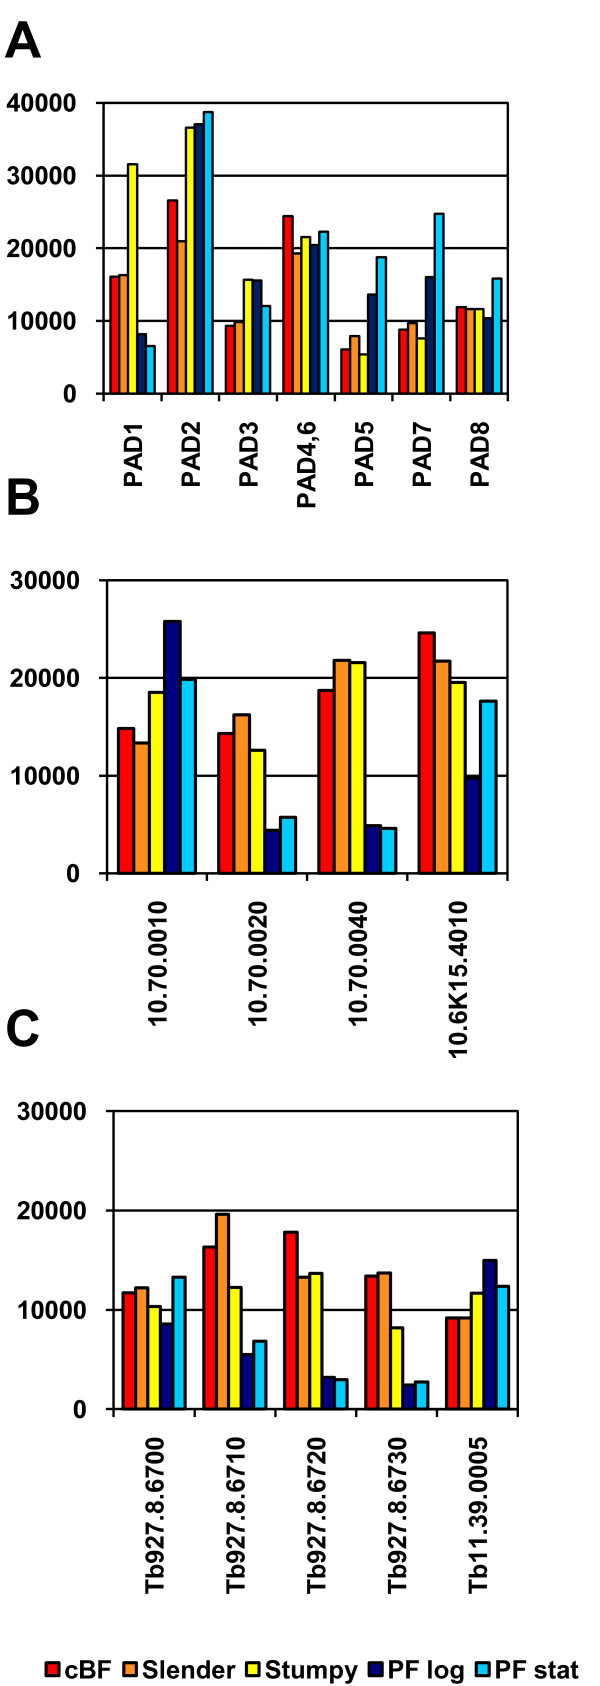
Differential expression of tandemly arrayed genes. A. The PAD gene array of carboxylate transporter proteins (PAD1, Tb9277.5930, PAD2, Tb927.7.5940, PAD3, Tb927.7.5950, PAD4, Tb927.7.5960, PAD5, Tb927.7.5970, PAD6, Tb927.7.5980, PAD7, Tb927.7.5990, PAD8, Tb927.7.6000). Not shown is the unlinked PAD-like gene, Tb927.8.1650, which is expressed constitutively to low levels. B. A cluster of four genes encoding proteins of a major facilitator family. C. A cluster of genes with five to six transmembrane domains. Four genes are tandemly linked on chromosome 10 and the fifth, more divergent gene (Tb11.39.0005) is on chromosome 11.